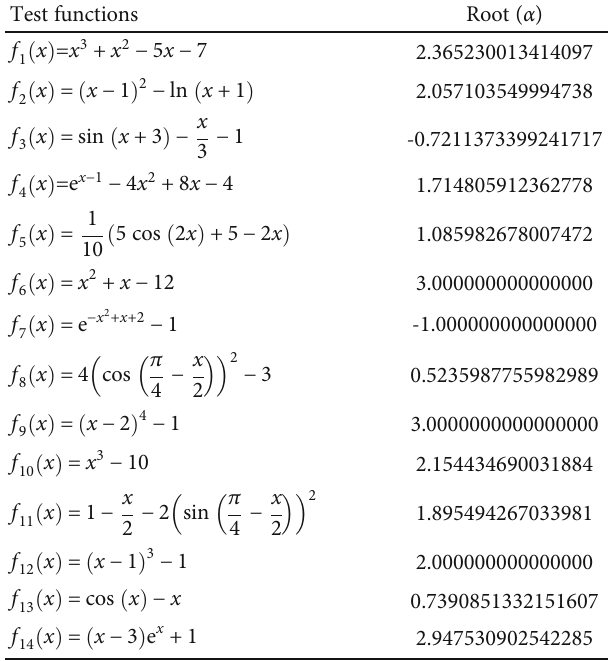
Table 2: Test functions and their roots. Test